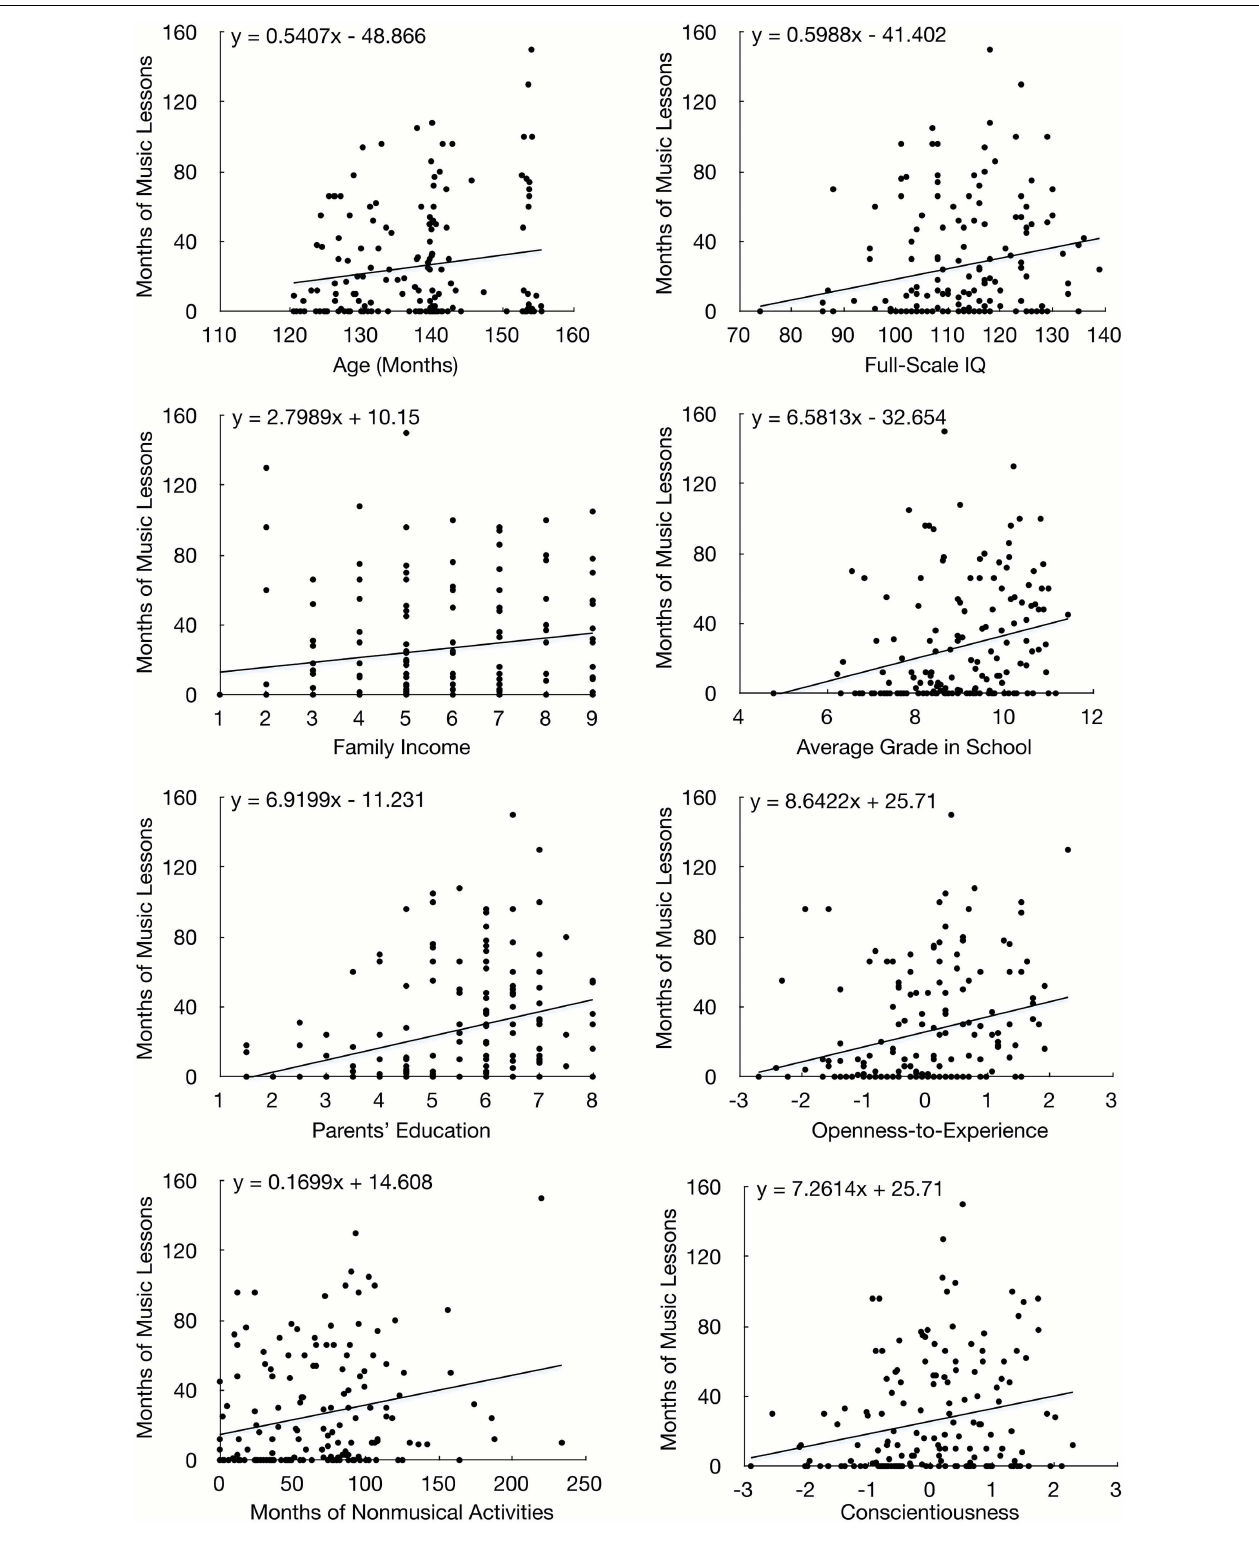
FIGURE 2 | Study 2 (children): scatterplots of significant simple associations between predictor variables ( X -axis) and months of music lessons ( Y -axis) .